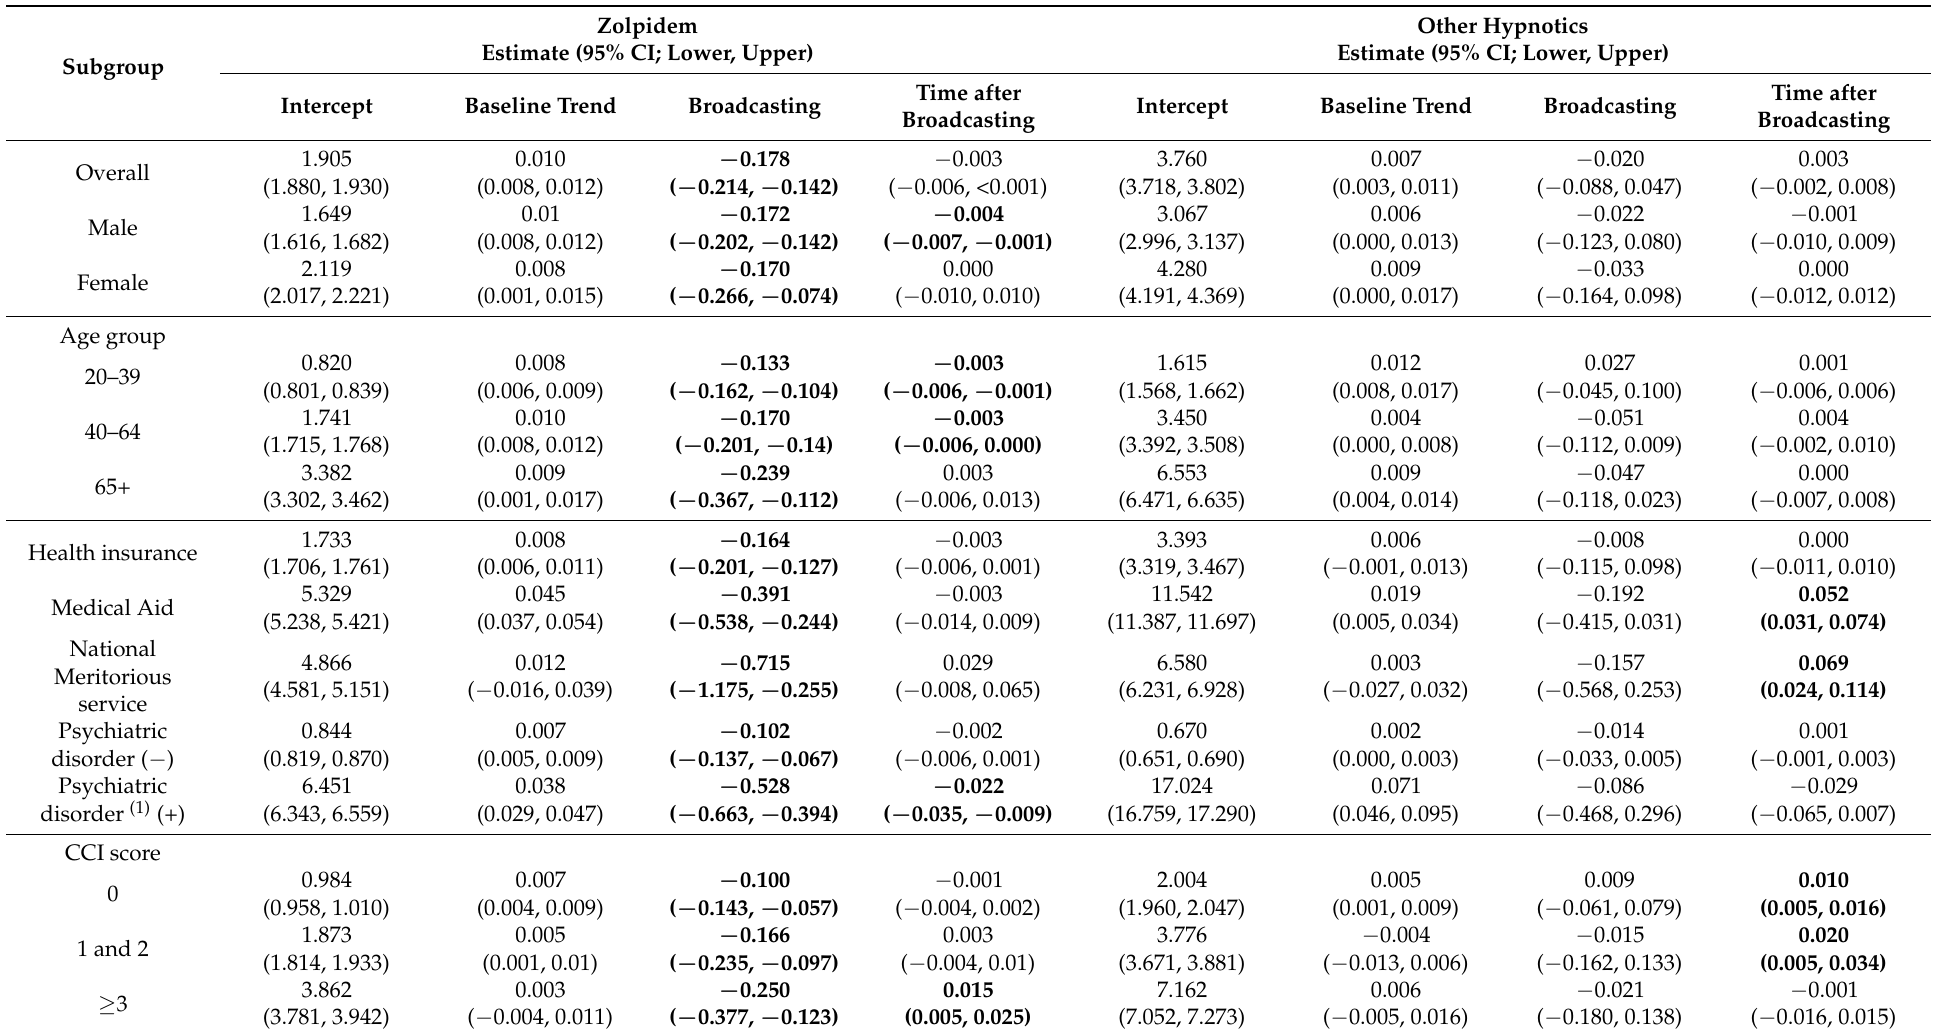
Table 2. Subgroup analysis showing changes in the prescription rate before and after broadcasting. (unit: patients using the study medications/total outpatients monthly, percentage). Zolpidem Estimate (95% CI; Lower, Subgroup